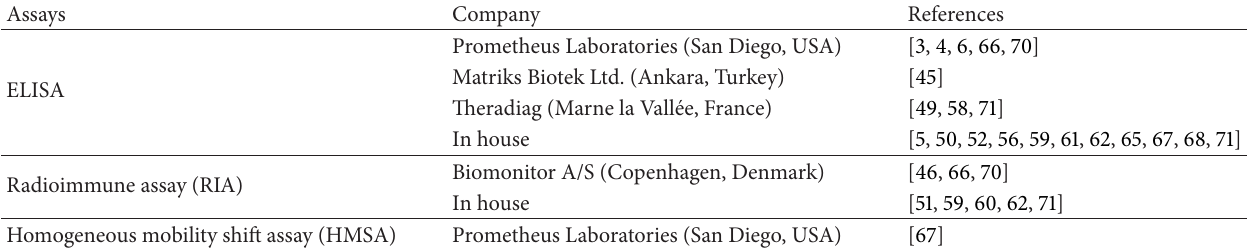
Table 1: Summary of the assays used in cited references for drug serum trough levels and ADAb